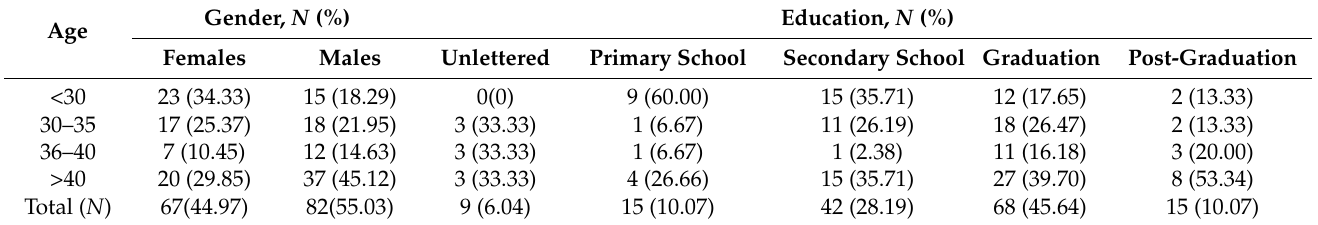
Table 2. Age-wise distribution of gender and education level of the respondents ( N =